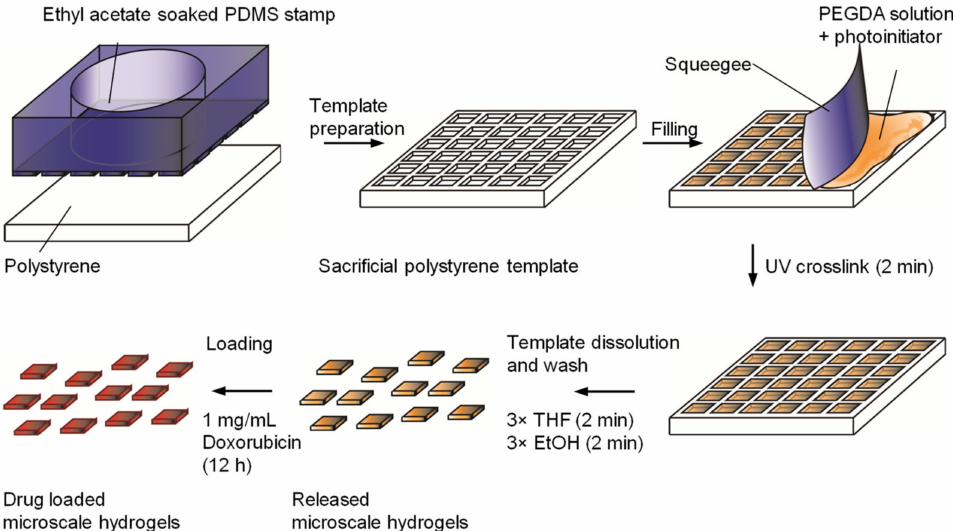
Figure 1. A schematic depiction of the process of microscale hydrogel formation and loading with doxorubicin, repurposed for use in local glioblastoma therapeutics. Utilization of semi-automated solvent-assisted microcontact molding of sacrificial templates allows the production of large numbers of hydrogels with precise dimensions, without batch-to-batch